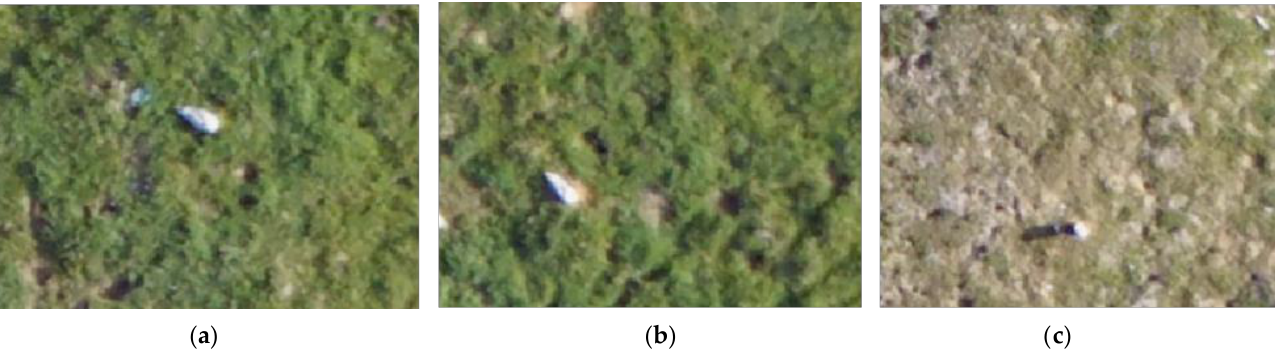
Figure 2. Images representing the different behaviors perceived during the manual identification of the individuals: ( a ) HG categorized as lying down (sitting), without a visible nest nearby; ( b ) HG lying down on a nest (incubating), based on the presence of nesting material under the individual; ( c ) LBBG standing, based on the presence of a long shadow coming from the individual.